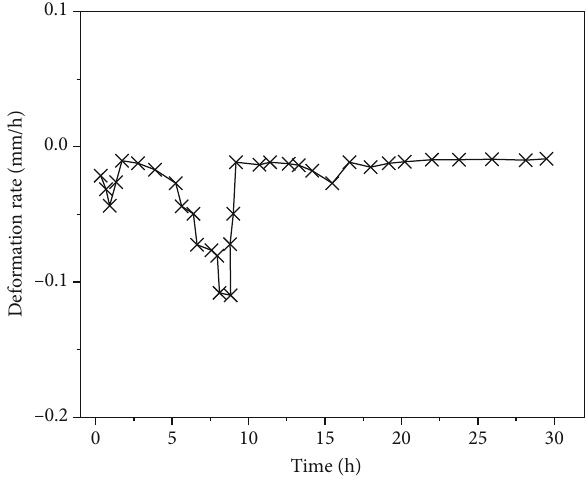
Figure 15: Deformation rate for soil HS.